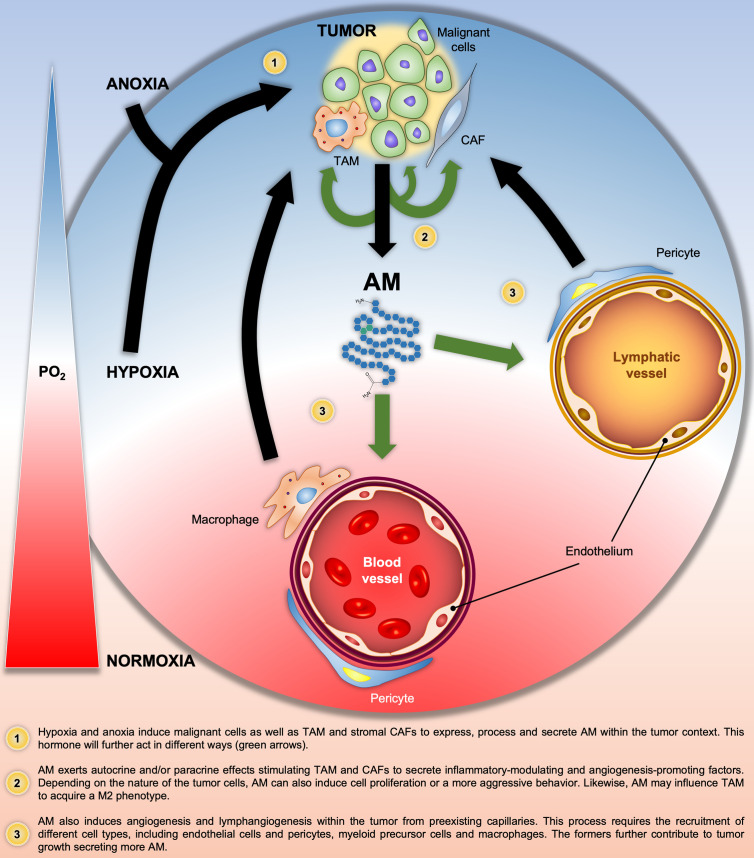
Graphical summary of the Adrenomedullin (AM)-related pathologic processes in solid tumors. Black and green arrows indicate the progression of the pathologic processes and the AM target cells, respectively. PO2, O2 partial pressure.